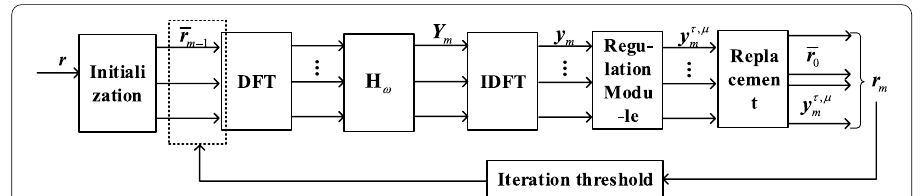
Fig. 5 Regularized extrapolator for compressive OFDM